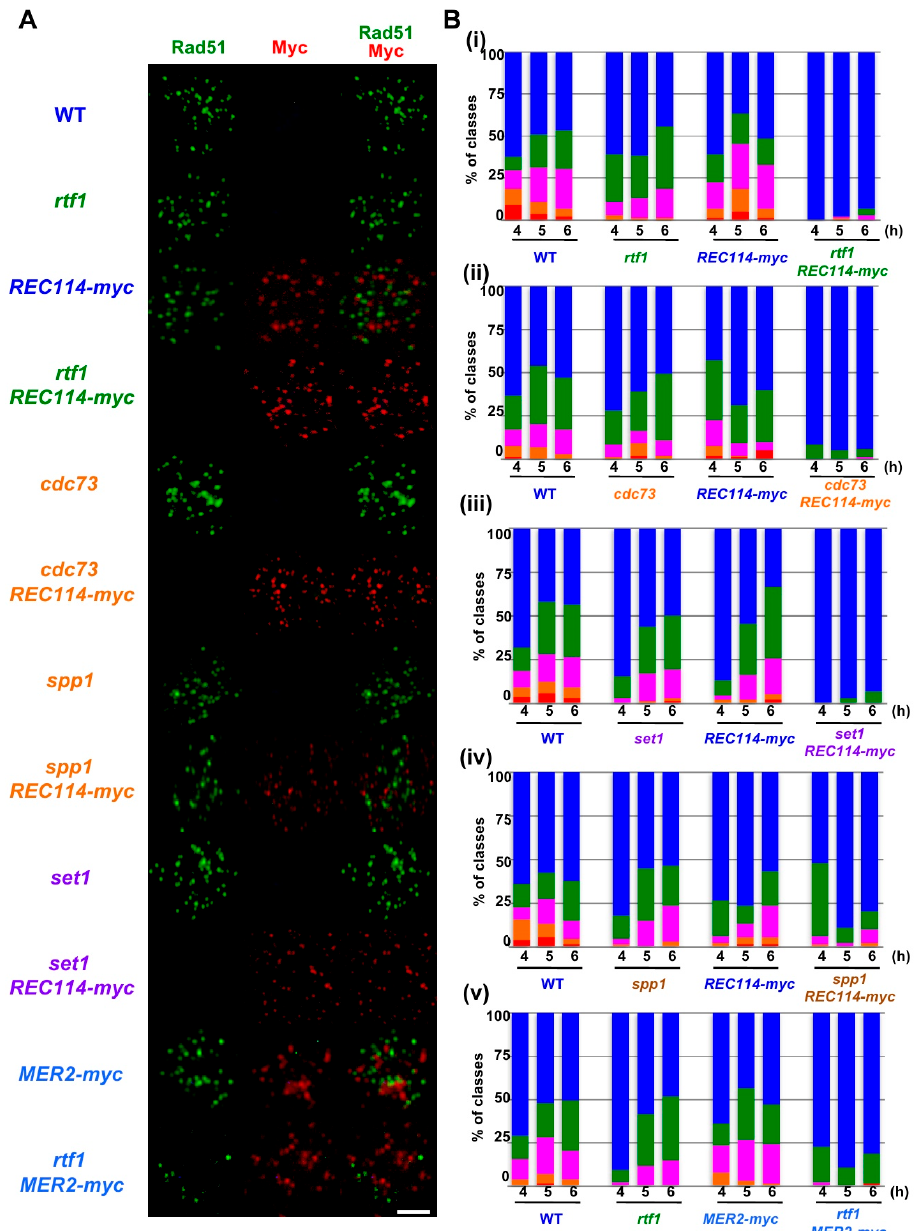
Figure 2. The REC114-myc showed a synthetic defect in Rad51-foci formation with histone modification mutations. ( A ) Nuclear spreads from cells undergoing meiosis in various strains were stained with anti-Rad51 (green), anti-myc (red, Rec114/Mer2), and DAPI (blue). The representative images of Rad51/myc/DAPI-staining at 4 h in each strain are shown. Wild type, MSY831/833; rtf1 , ZYY839; REC114-myc , ZYY411; rtf1 REC114-myc , ZYY391; cdc73 , ZYY811; cdc73 REC114-myc , ZYY736; spp1 , ZYY892; spp1 REC114-myc , ZYY739; set1 , ZYY733; set1 REC114-myc , ZYY1812; MER2-myc , ZYY893; rtf1 MER2-myc , ZYY874. Bar = 2 μ m. ( B ) The number of Rad51 foci per spread at 4, 5, and 6 h was counted and classified into a spread with less than 5 (Rad51-negative, blue), 6–20 (green), 21–35 (purple), 36–50 (orange), and >50 (red) foci. The graphs show percentages of each class of Rad51-foci numbers. The number is a sum from three independent time courses ( n = 126; 42 × 3). Data of wild-type, rtf1, and REC114-myc cells in (i)–(v) were obtained by independent time courses. Statistics for comparison between strains are shown in Table S2.